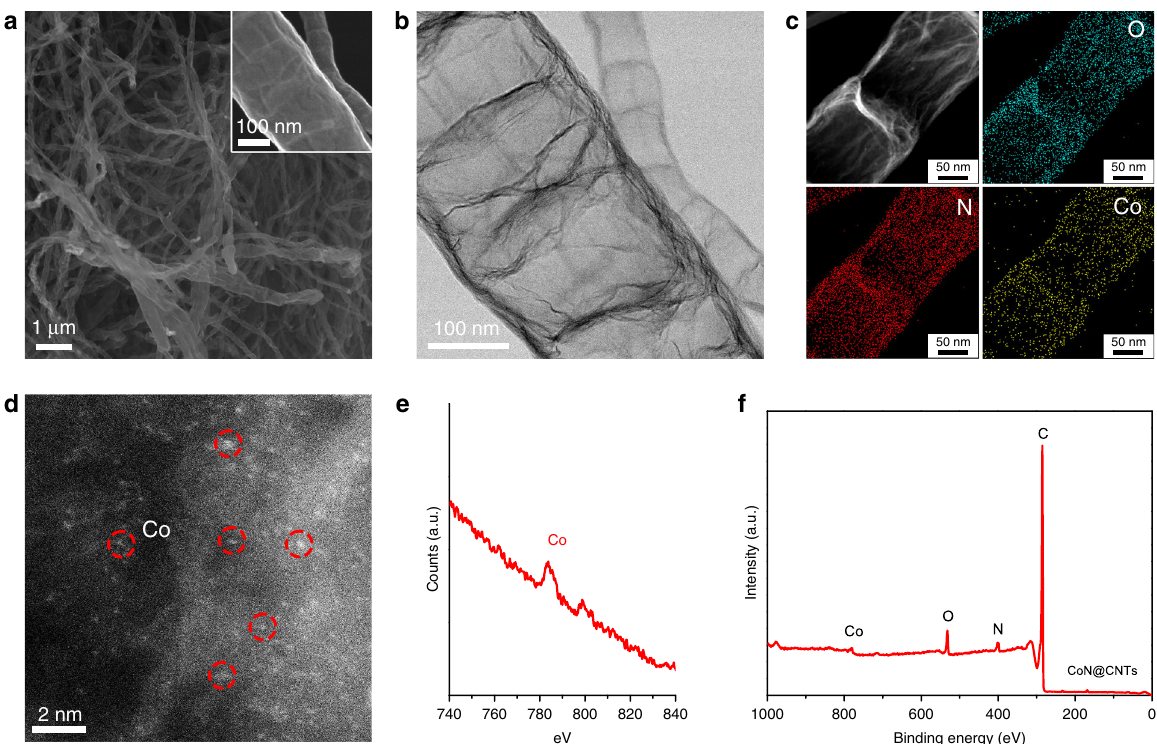
Fig. 1 Microstructural analysis of the CoN@CNTs catalyst. a SEM images of CoN@CNTs. Inset is the high-resolution SEM image of a selected area of CoN@CNTs. b TEM image of CoN@CNTs showing a bamboo-like structure of the carbon nanotubes. c HAADF – STEM image and corresponding EDS maps of CoN@CNTs for O, N, and Co. d HAADF-STEM image of the CoN@CNTs showing many Co atoms (circled in red) well-dispersed in the carbon layers. e EELS analysis of selected area in d showing the signals of Co. f XPS elemental survey of